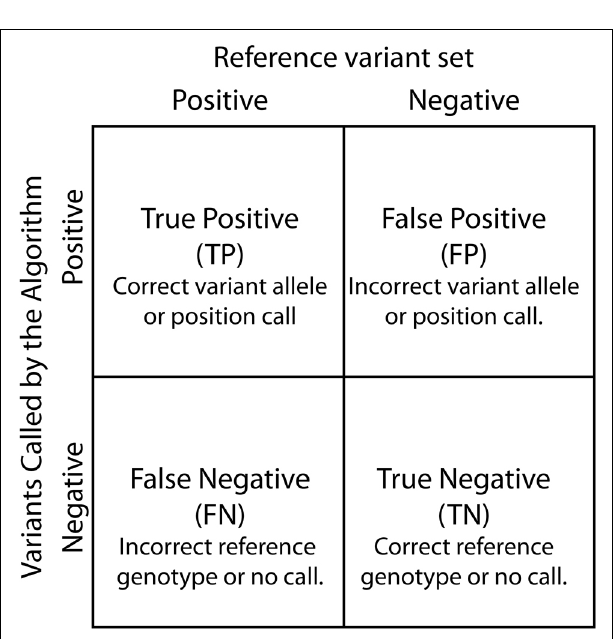
table: true positive (TP), true negative (TN), false positive (FP), and false negative (FN), are used to assess algorithm performance.